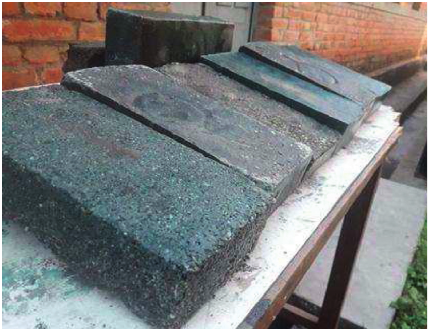
Figure 10: Casted